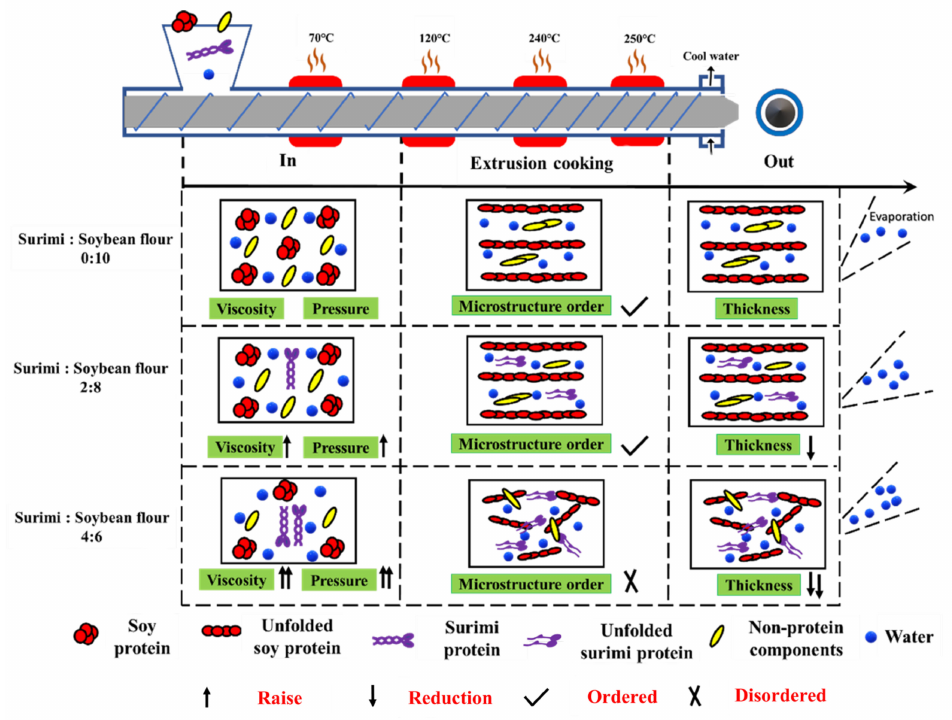
Figure 5. The mechanism on structure properties of dual-protein extrudates as affected by the ratio of surimi and soybean